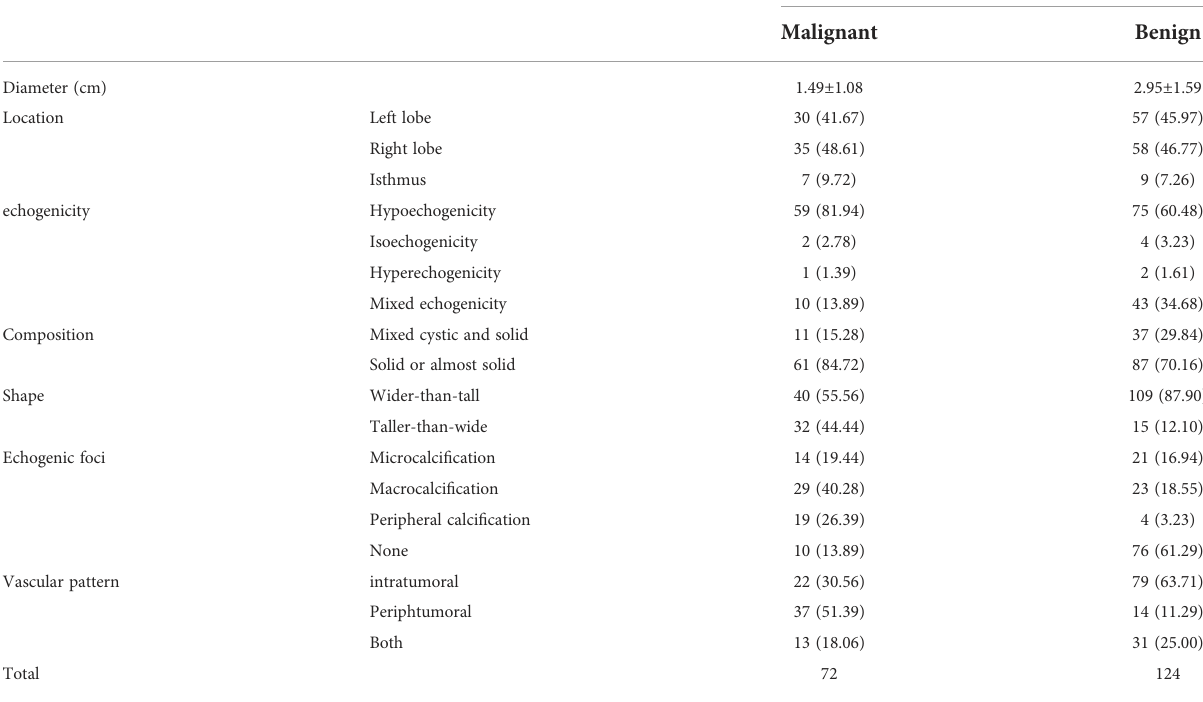
TABLE 1 Imaging features of the thyroid